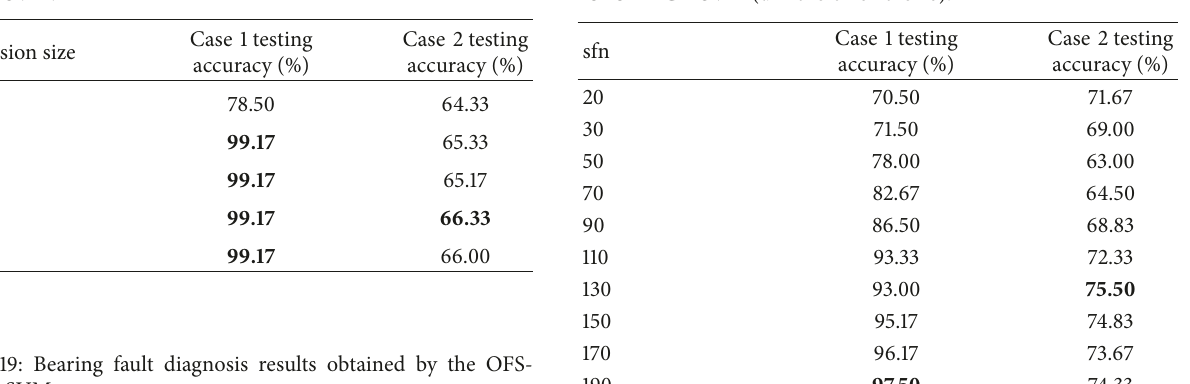
Table 18: Bearing fault diagnosis results obtained by the OFS- SNPEL-SVM.